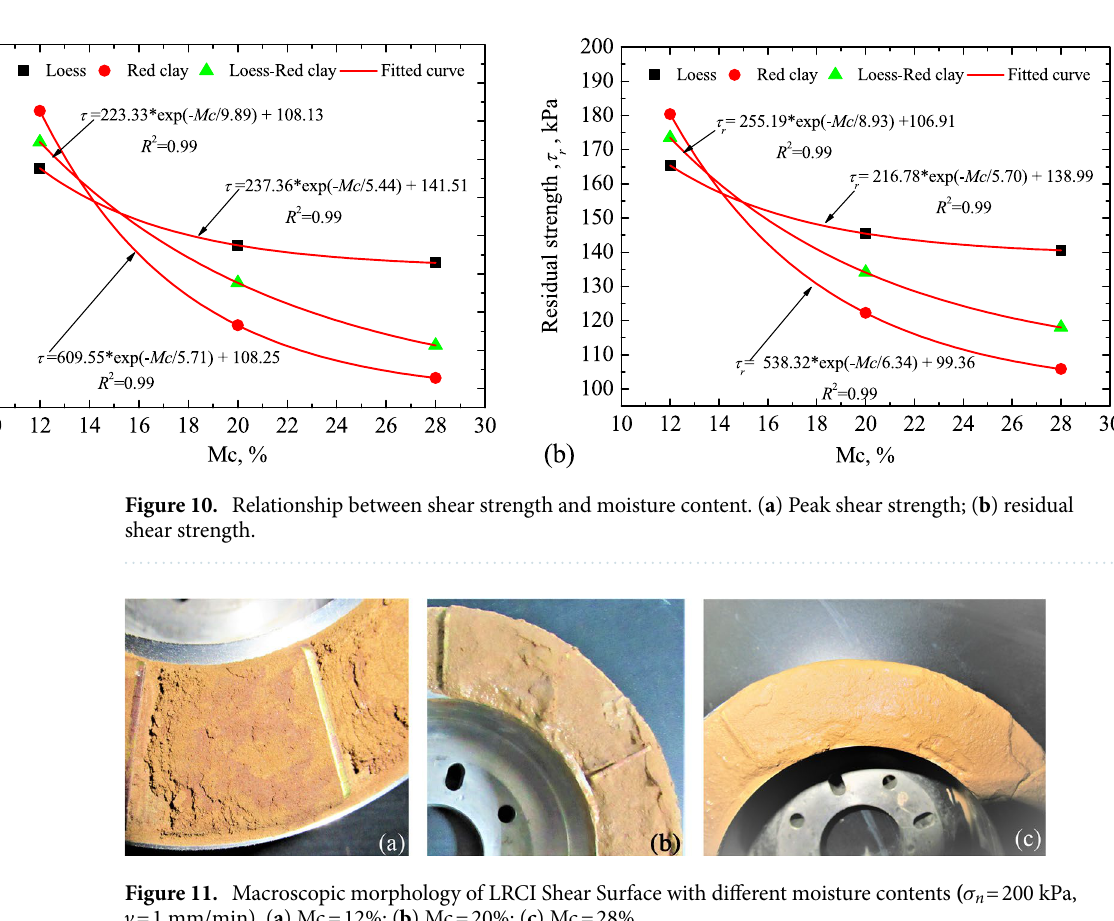
Figure 11. Macroscopic morphology of LRCI Shear Surface with different moisture contents ( σ n = 200 kPa, v = 1 mm/min). ( a ) Mc = 12%; ( b ) Mc = 20%; ( c ) Mc =